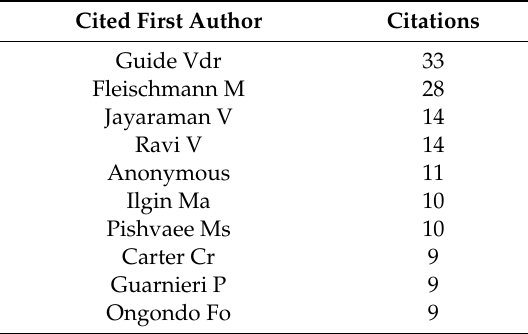
Table 6. Citation analysis: Top 10 most cited first